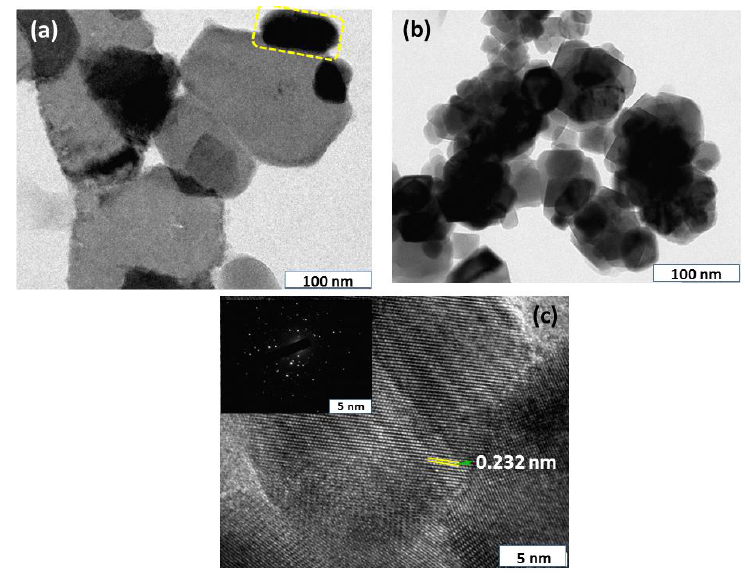
Figure 4. TEM images of ( a ) APD-AgNPs, ( b ) APD-AgNPs-Hg 2+ complex and ( c ) HRTEM of APD- AgNPs-Hg 2+ complex with SAED image (inset). APD-AgNPs-Hg 2+ complex with SAED image (inset).